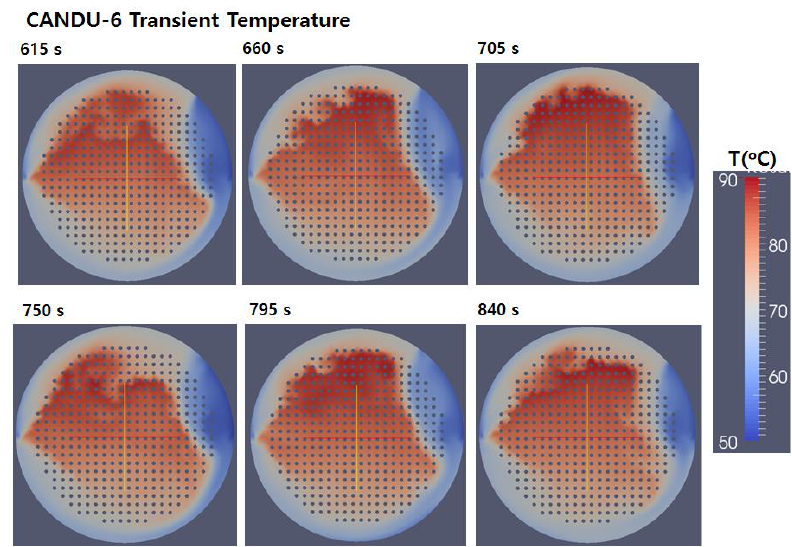
Figure 8. Temperature Distribution at z = 0; 615 – 840 s.